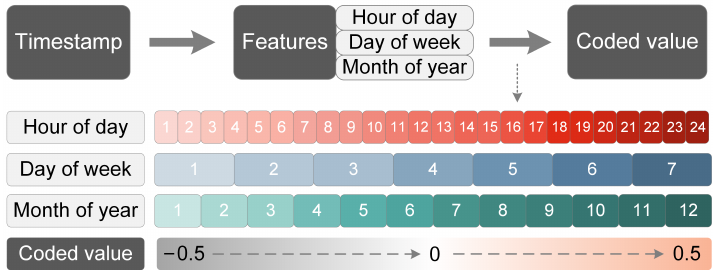
Figure 3. Illustration of temporal data encoding.